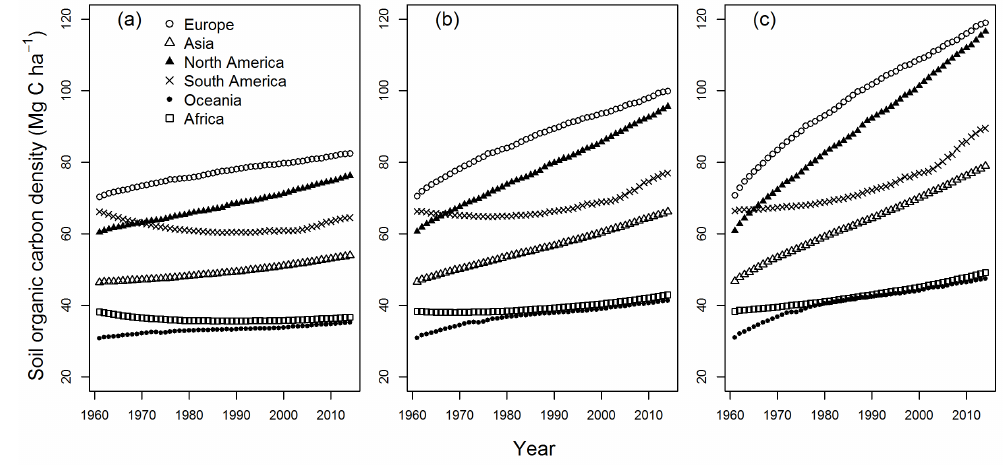
Figure 3. SOC evolution of five continents in the main global cereal cropping regions under different above-ground crop residue retention rates of 30% (a) , 60% (b) and 90% (c) .